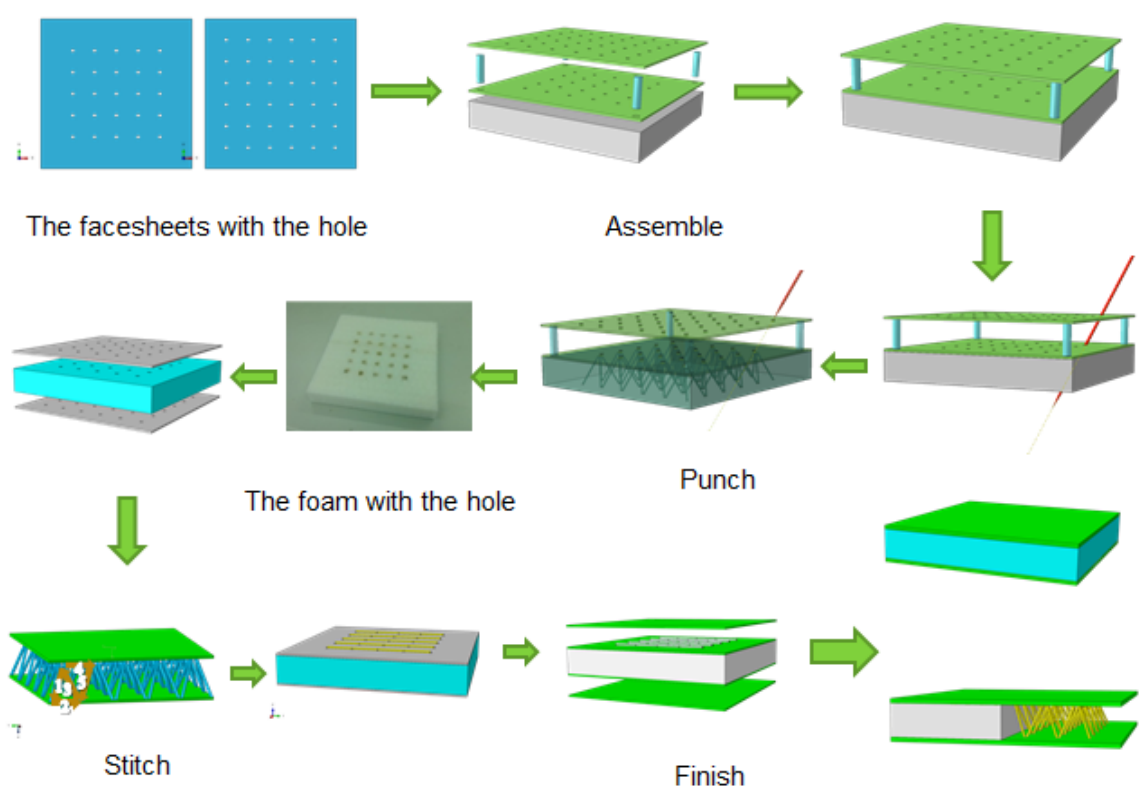
Figure 1: The process for the fabrication of the pyramidal lattice stitched foam sandwich